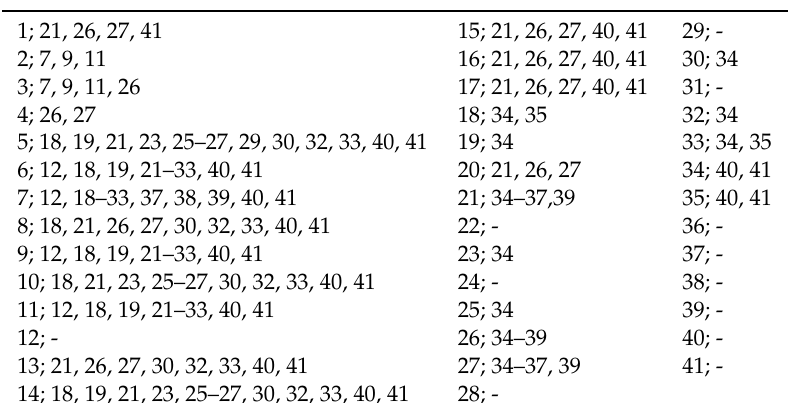
Table 3. Diagonal table of dissimilarities that resulted from the Dunn